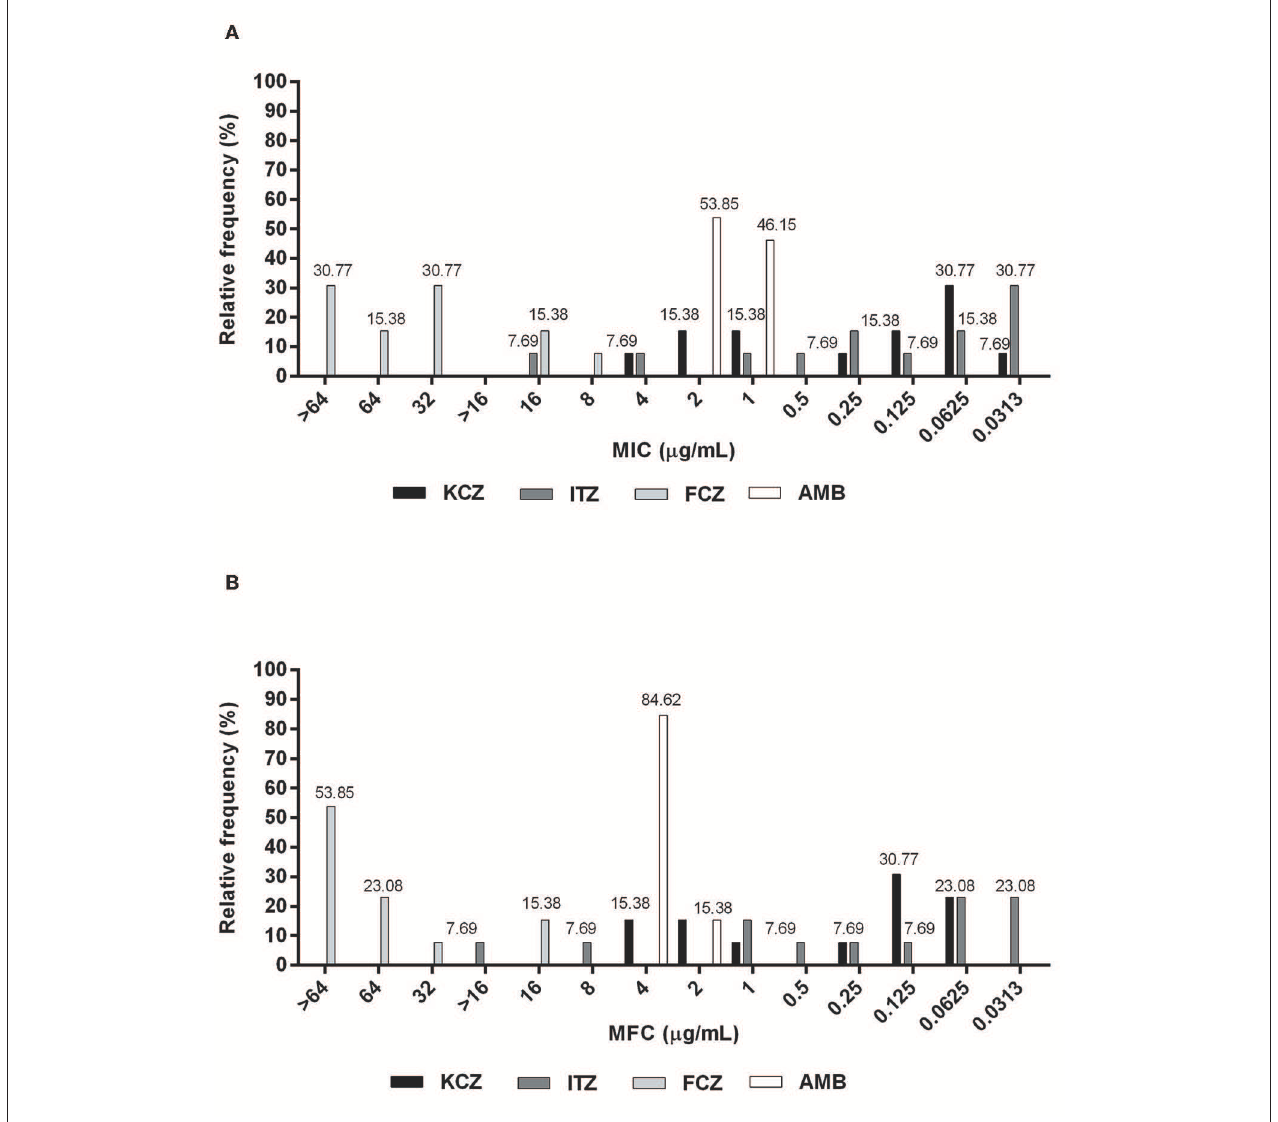
FIGURE 1 | Relative frequency of (A) MIC ( µ g/mL) and (B) MFC ( µ g/mL) values obtained from Malassezia pachydermatis isolates against commercial allopathic